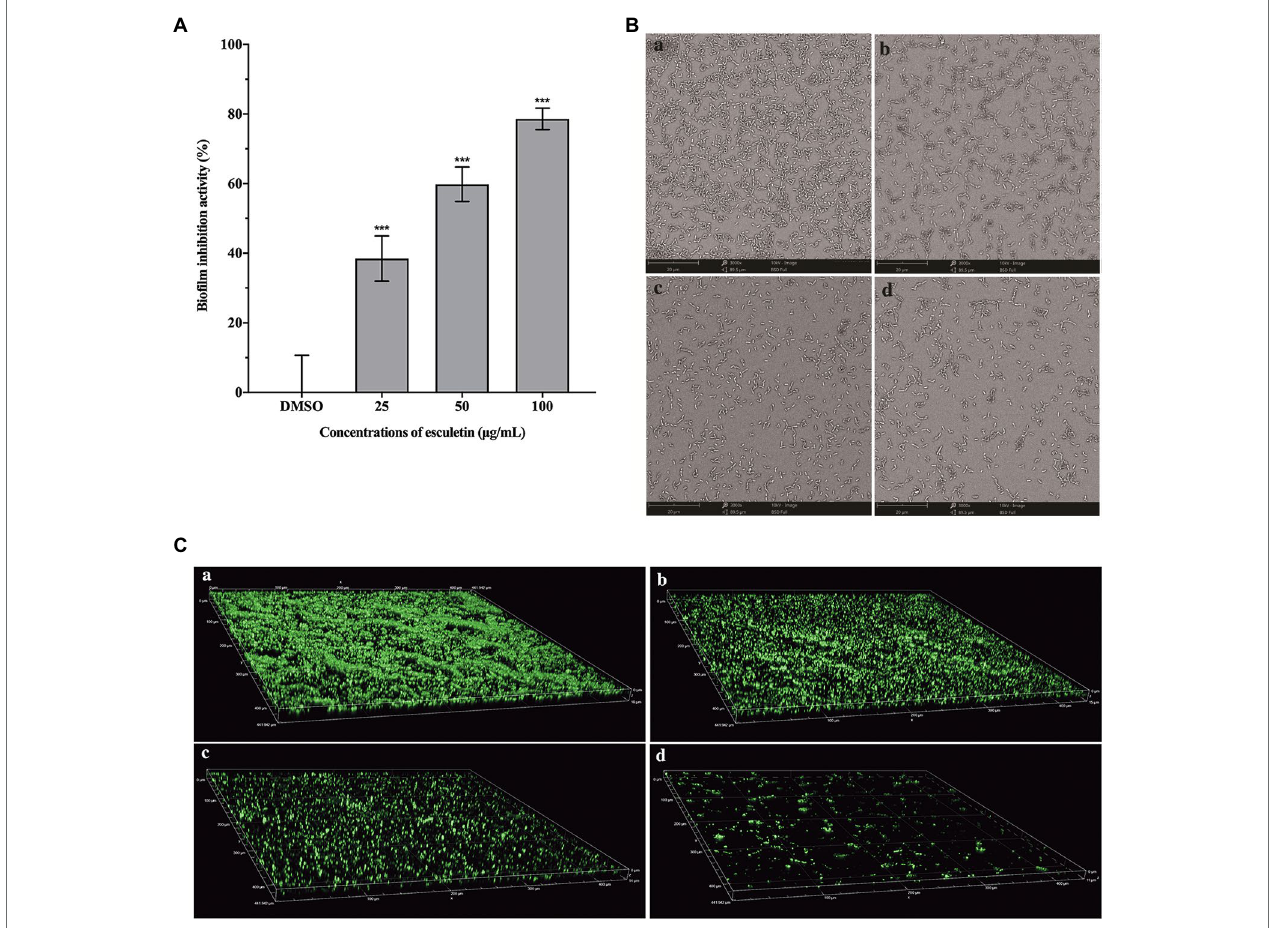
FIGURE 5 | Effect of esculetin on biofilm formation. (A) Quantitative analysis of biofilm biomass, (B) SEM images, and (C) CLSM images of A. hydrophila SHAe 115 biofilms treated with (a) DMSO, (b) 25 μ g/ml, (c) 50 μ g/ml, and (d) 100 μ g/ml of esculetin. Data are presented as the inhibition rate of mean ± SD of three independent experiments. *** p < 0.001 compared to the DMSO control group by one-way